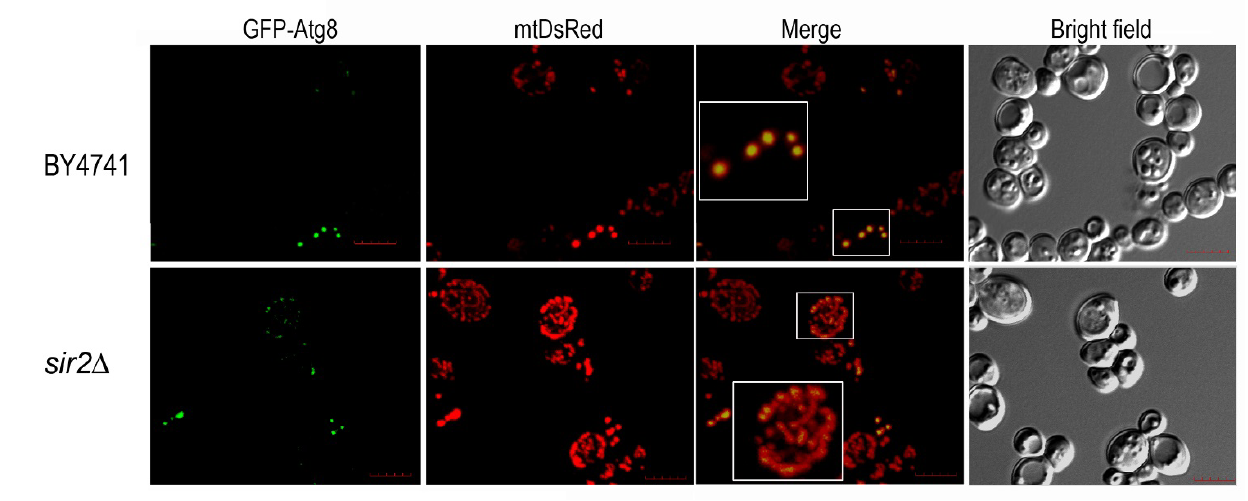
FIGURE 3: SIR2 deleted cells exhibit increased mitochondrial mass and altered mitochondria network. Wild type and sir2 D (background BY4741) cells expressing, GFP-Atg8 and mtDsRed were analyzed for mitophagy by confocal fluorescence microscopy. The cells were collect- ed and analyzed at day 3 of chronological lifespan. Mitophagy was analyzed by the pattern of co-localization between GFP-Atg8 and mtDsRed, as exemplified. Images were acquired in a confocal Olympus FLUOVIEW microscope with an Olympus PLAPON 60X/oil objective, with a numerical aperture of 1.35. GFP and DsRed were excited with and argon laser and a helium-neon laser (GFP: 488 nm excitation; DsRed: 559 nm excitation). Background reduction was performed with appropriate saturation levels using software FV1000 (Olympus) and Adobe Photoshop CS. Image stacks for analysis were acquired with sequential steps of 0.25 to 0.5 µm per plane in the z-direction and a total thickness of 4-6 µm. The acquired stacks were rendered with FV1000 software. Scale bars: 5